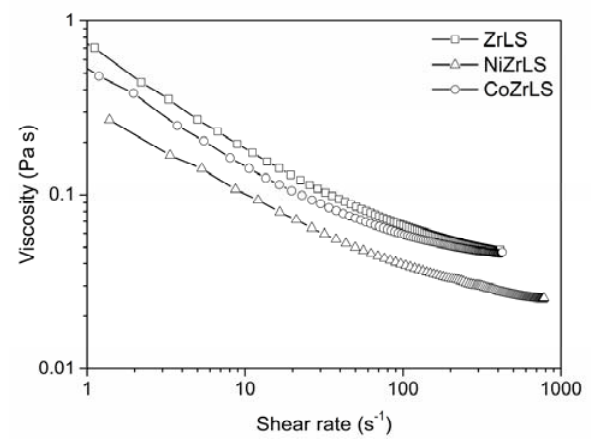
Figure 2. Rheological behavior of zirconia-based